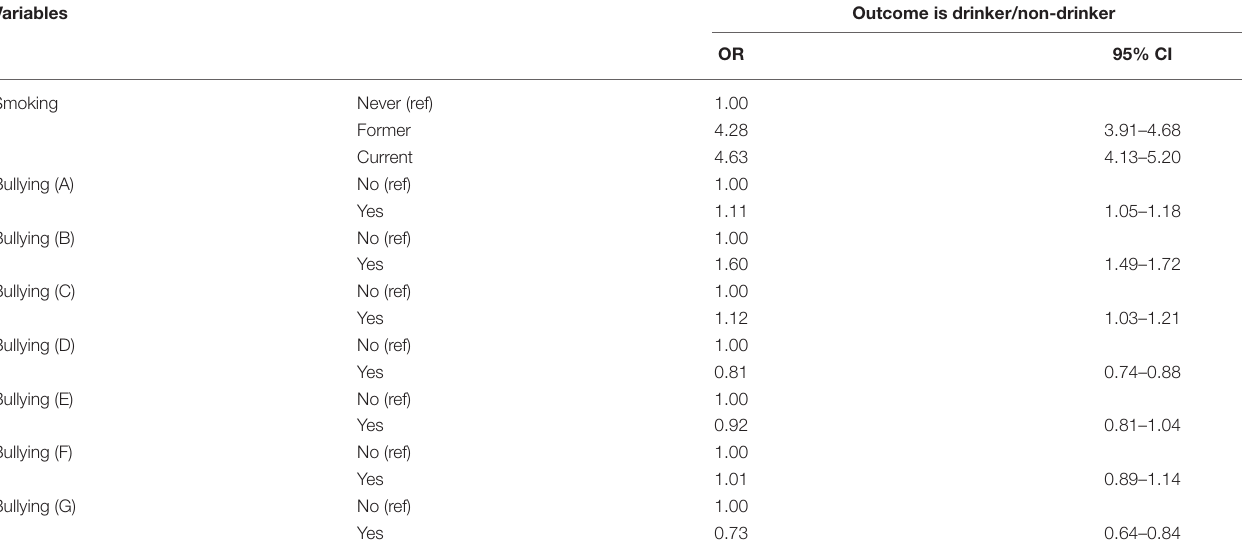
TABLE 4 | Multivariate logistic model for factors associated with ever drinking, N = 31,825 (model 1). Variables